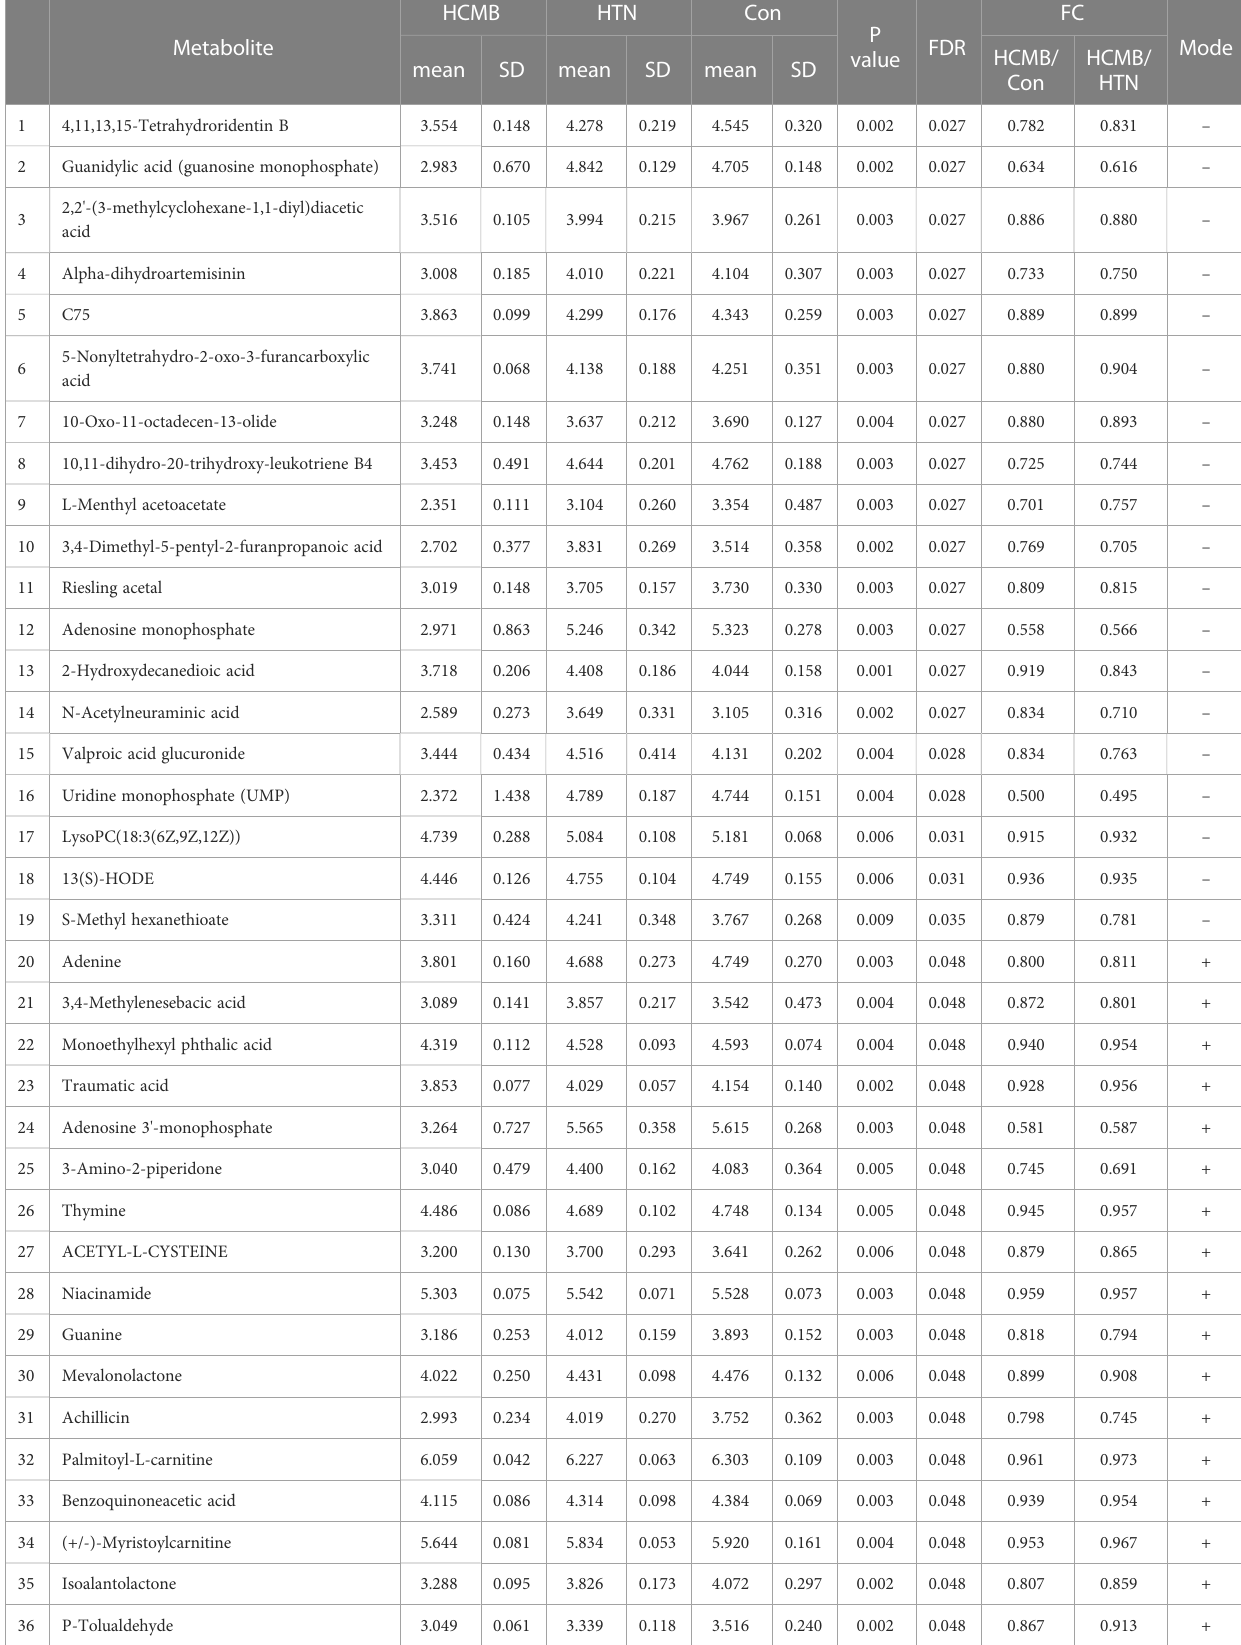
TABLE 2 LC-MS analysis of metabolites downregulated in the HCMB group compared to the HTN and Con groups by the rank-sum test.